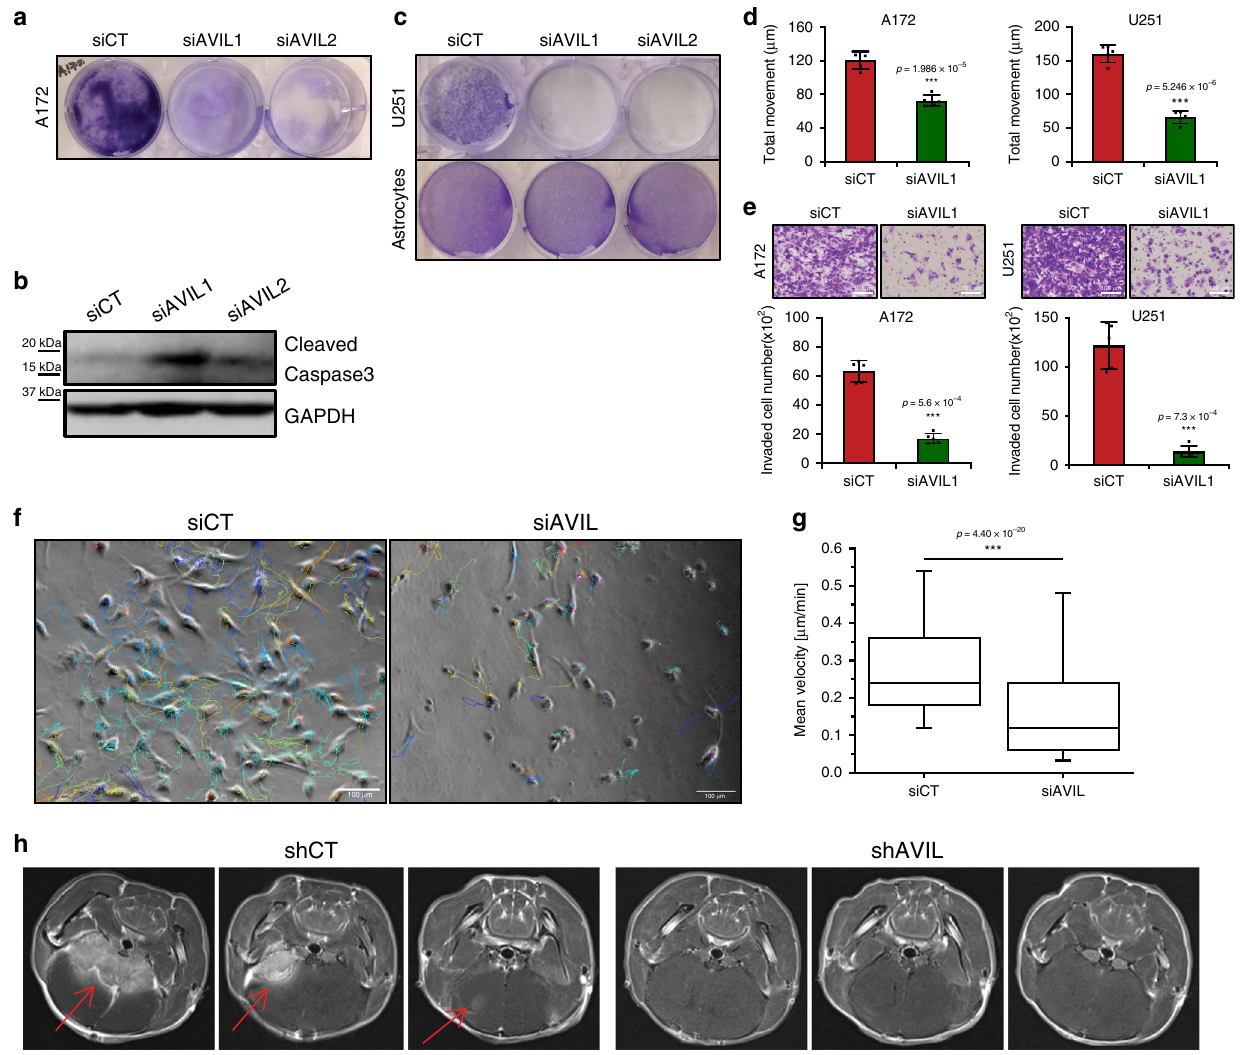
Fig. 3 AVIL overexpression is crucial for GBM cell line tumorigenesis. a Crystal violet staining of A172 cells transfected with siAVIL1, siAVIL2, or siCT after a week of transfection. b Western blot measuring cleaved Caspase3 in A172 cells transfected with the siRNAs. c Effect of AVIL silencing in U251 cells (upper) and astrocytes (lower). d Wound-healing measuring cell migration at 48 h after siRNA transfection in A172 (left), and U251 cells (right) ( n = 5, two-sided Student ’ s t- test). e Tumor cell invasiveness was measured by matrigel-coated transwell assay at 48 h after transfection. Shown are results from A172 (left), and U251 cells (right) ( n = 5, two-sided Student ’ s t- test). f Movement of A172 cells was observed over 24 h period of time by live-cell imaging, starting 24 h after transection with either siCT (left) or siAVIL (right). Shown are representative images depicting the last timepoint of the experiment with overlaid lines tracking the movement of individual cells. g Mean velocities of all cells tracked in the experiment depicted in f ( n > 150 cells quanti fi ed per condition) (box, 25 – 75 percentile; whisker, 5 – 95 percentile; bar in middle, median) (two-sided Student ’ s t- test). h Three representative MRI brain images of mice injected with U251 cells stably expressing shCT or shAVIL. Red arrows point to the area of tumor. Data are presented as mean values± SD in d